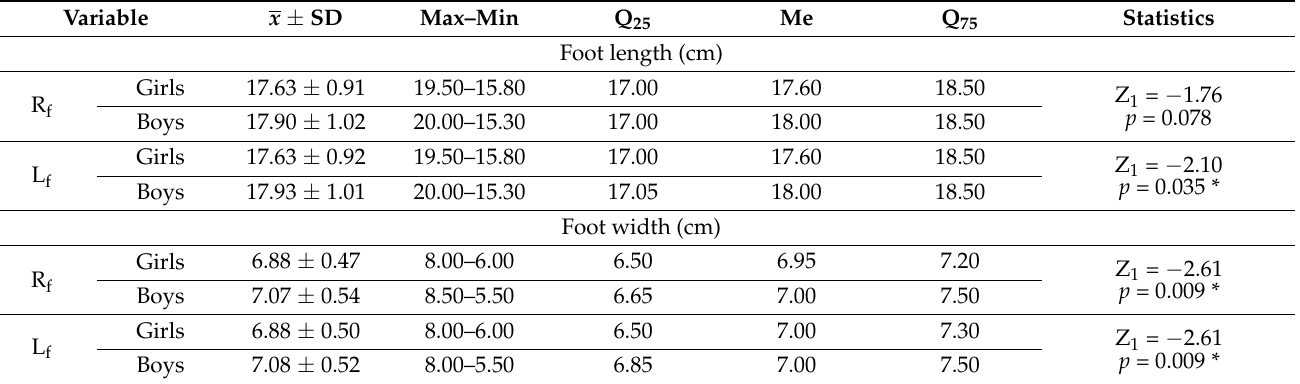
Table 2. Comparison of the length and width of the feet of the examined girls and